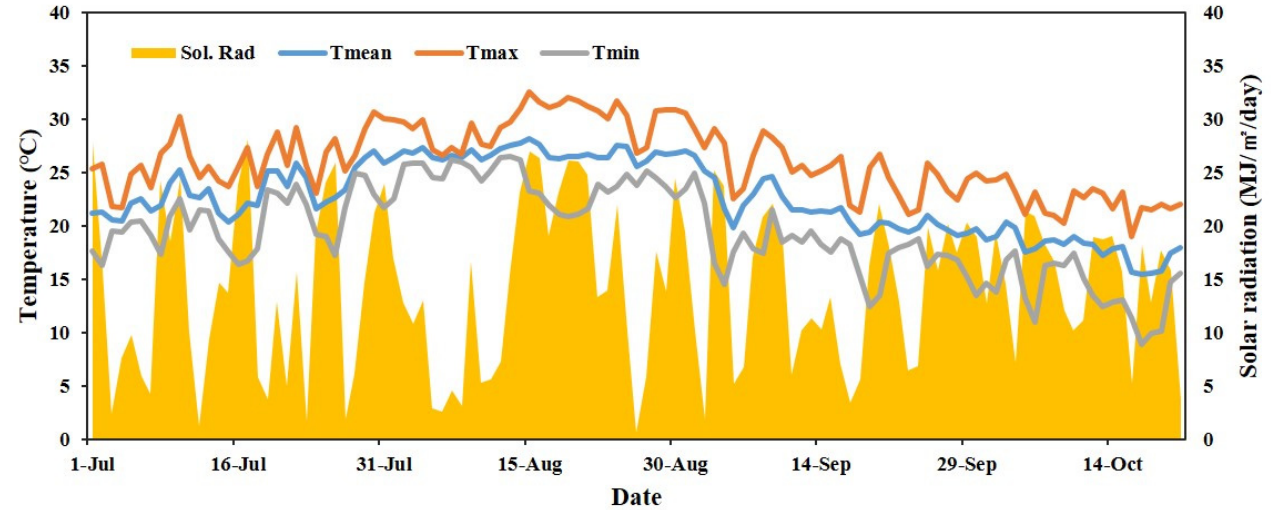
Figure 1. Daily average of maximum (Tmax), mean (Tmean), and minimum (Tmin) temperatures and solar radiation (Sol. Rad.) from July to October 2020.